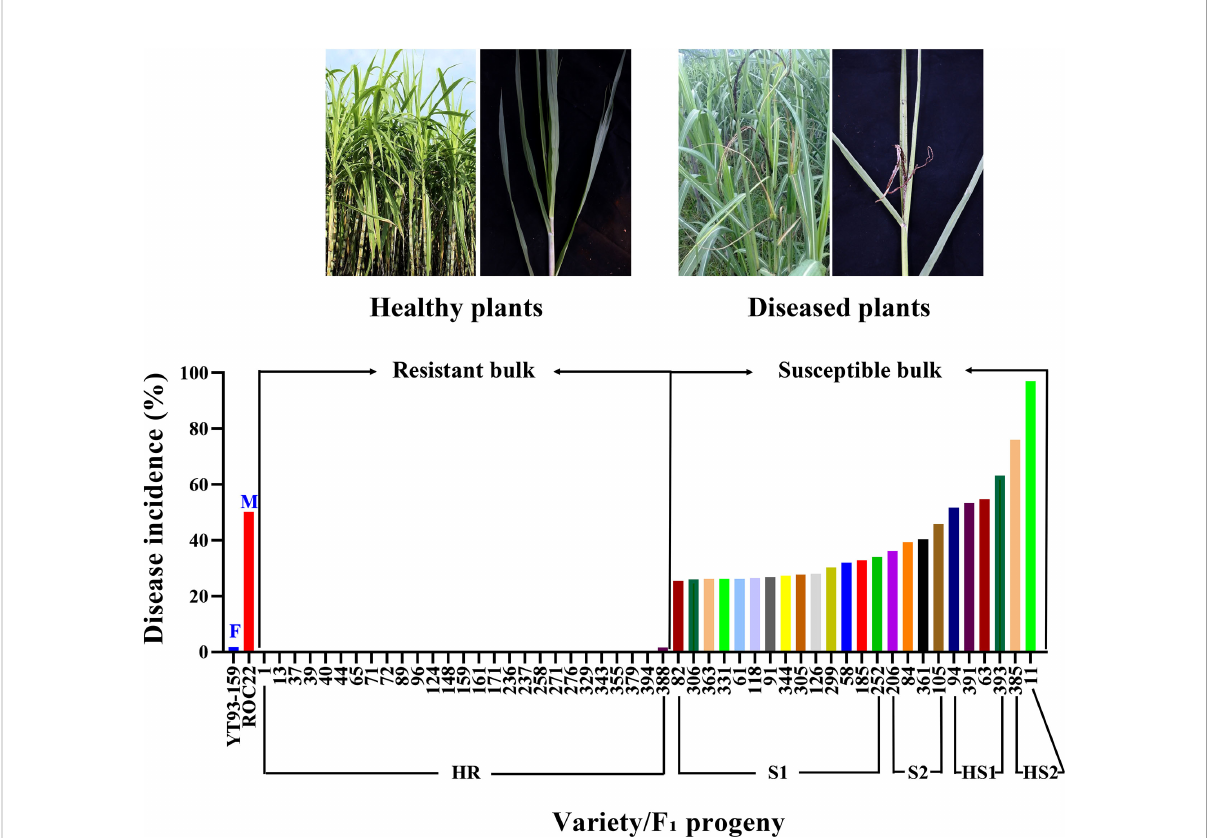
FIGURE 1 A graphic presentation of smut disease response by two selected extreme bulks of F 1 progenies and two parental varieties (X-axis) based on disease incidence (%) (Y-axis). F, female parent; M, male parent; HR, highly resistance; S1, susceptible 1; S2, susceptible 2; HS1, highly susceptible 1; HS2, highly susceptible